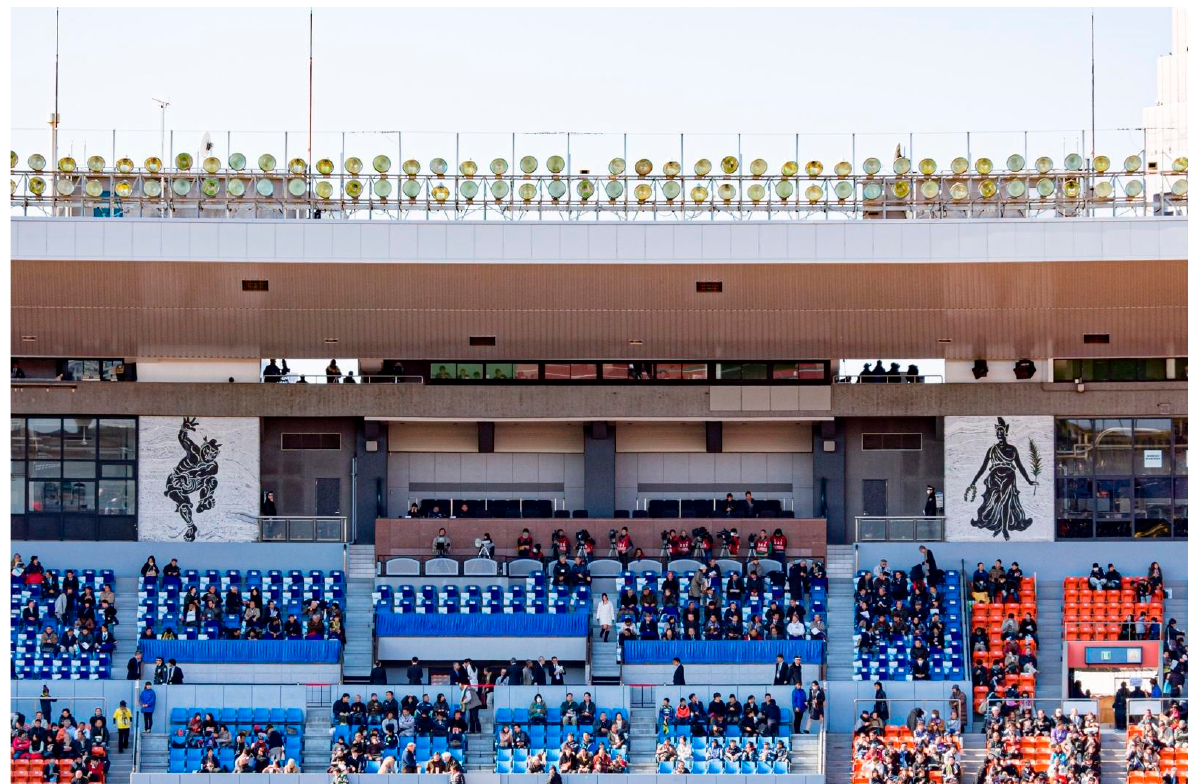
Figure 3. Hasegawa Luca’s “Victory and Glory” mosaic mural at Japan’s former National Stadium, 2019. Reproduced with permission from Ogikubo Kei; reprinted from Nikkei Business Publications.